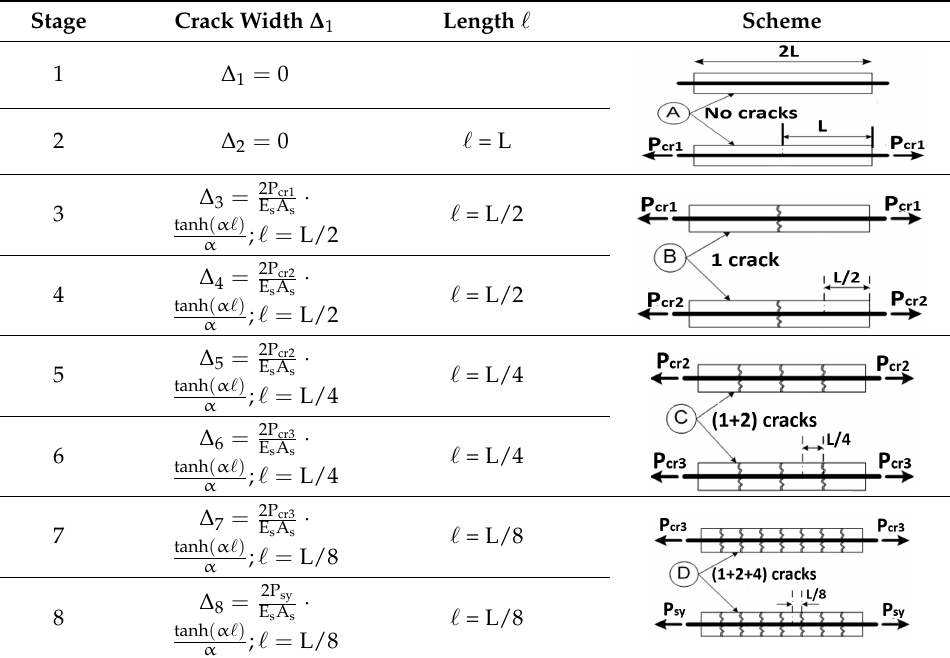
Table 3. Cracking stages and crack widths.